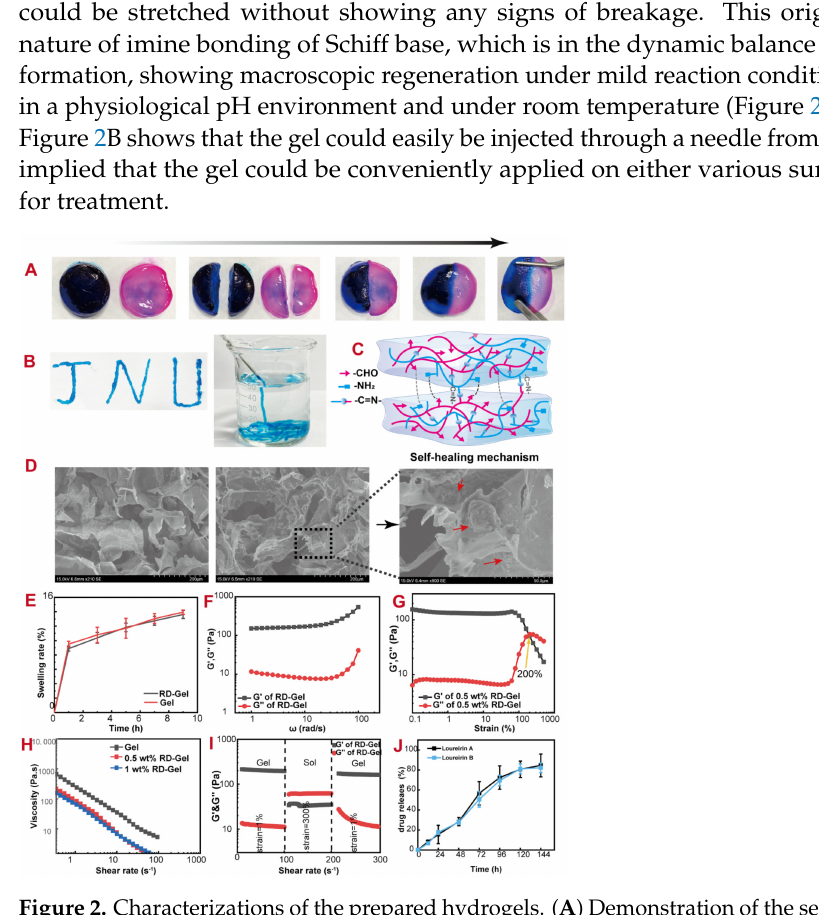
Figure 2. Characterizations of the prepared hydrogels. ( A ) Demonstration of the self-healing property of hydrogels. ( B ) Injectability of the hydrogel. ( C ) Schematic illustration of the reversible dynamic reaction of Schiff base bonds in hydrogel. ( D ) Morphological structure of the hydrogels visualized by SEM, scale bar: 200 µ m and 100 µ m. The red arrows represent Resina Draconis. ( E ) Swelling rate of hydrogels. ( F ) Frequency sweep of RD-Gel. ( G ) G (cid:48) and G (cid:48)(cid:48) of the hydrogel on strain sweep. ( H ) Shear viscosity tests of the hydrogels. ( I ) Rheological properties of the hydrogels in the test of changing strains. ( J ) Release of Loureirin A and Loureirin B from the RD-Gel in